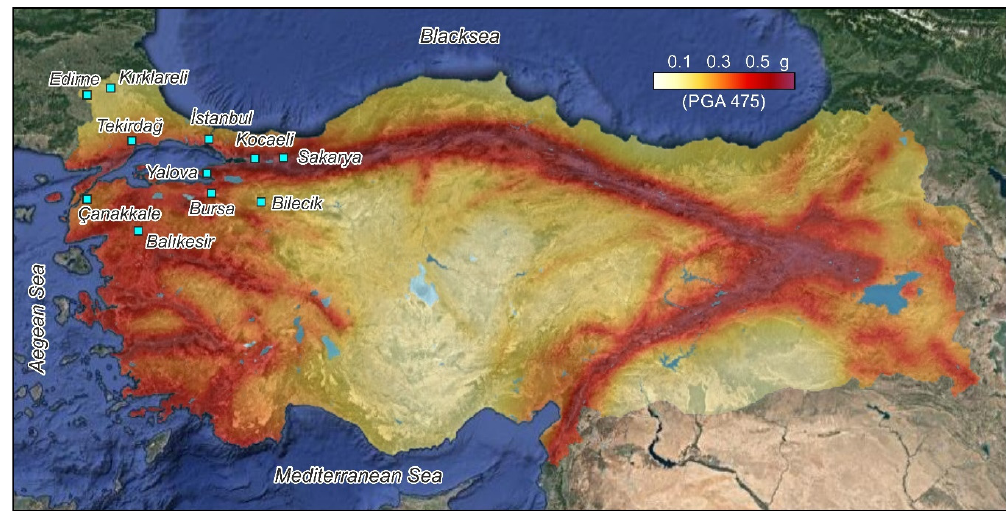
Figure 3. Turkish Earthquake Hazard Map [25] and the studied region.